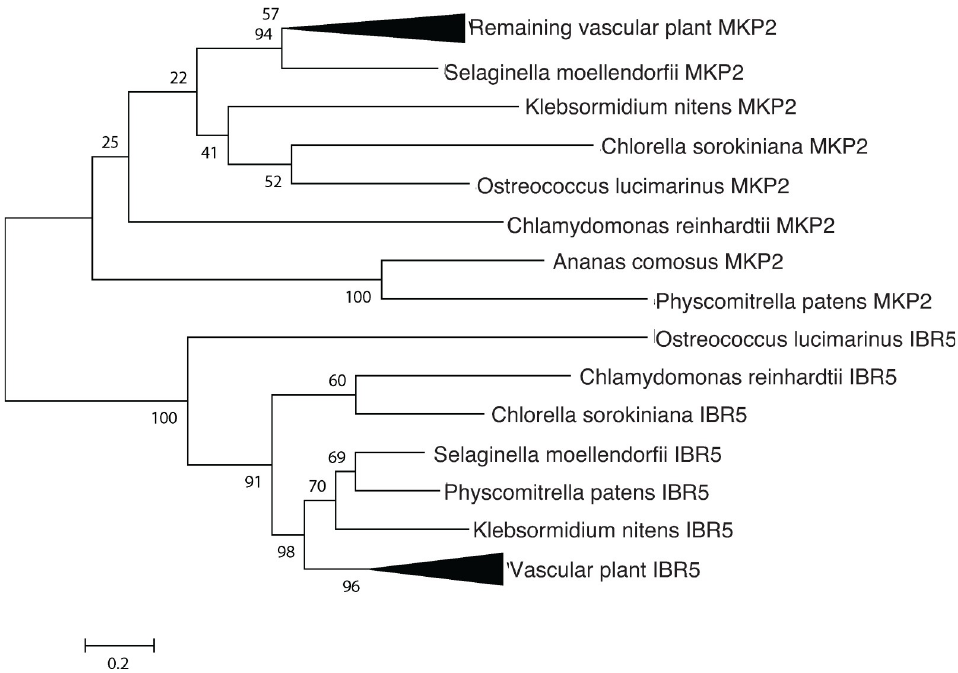
Fig 7. Phylogenetic analysis indicates sequence conservation, suggesting bona fide IAA signaling orthologs in Chlorella . IBR5, identified as a MAP Kinase Phosphatase with roles in auxin signaling, is compared with MKP2, which also contains a MAP kinase phosphatase domain and participates in other phytohormone signaling pathways. Putative auxin signaling orthologs and outgroups were identified by reciprocal BLAST searches, aligned with Clustal Omega (except for ABP1, aligned with Expresso) and analyzed using the LG+I substitution model in MEGA 6.06.